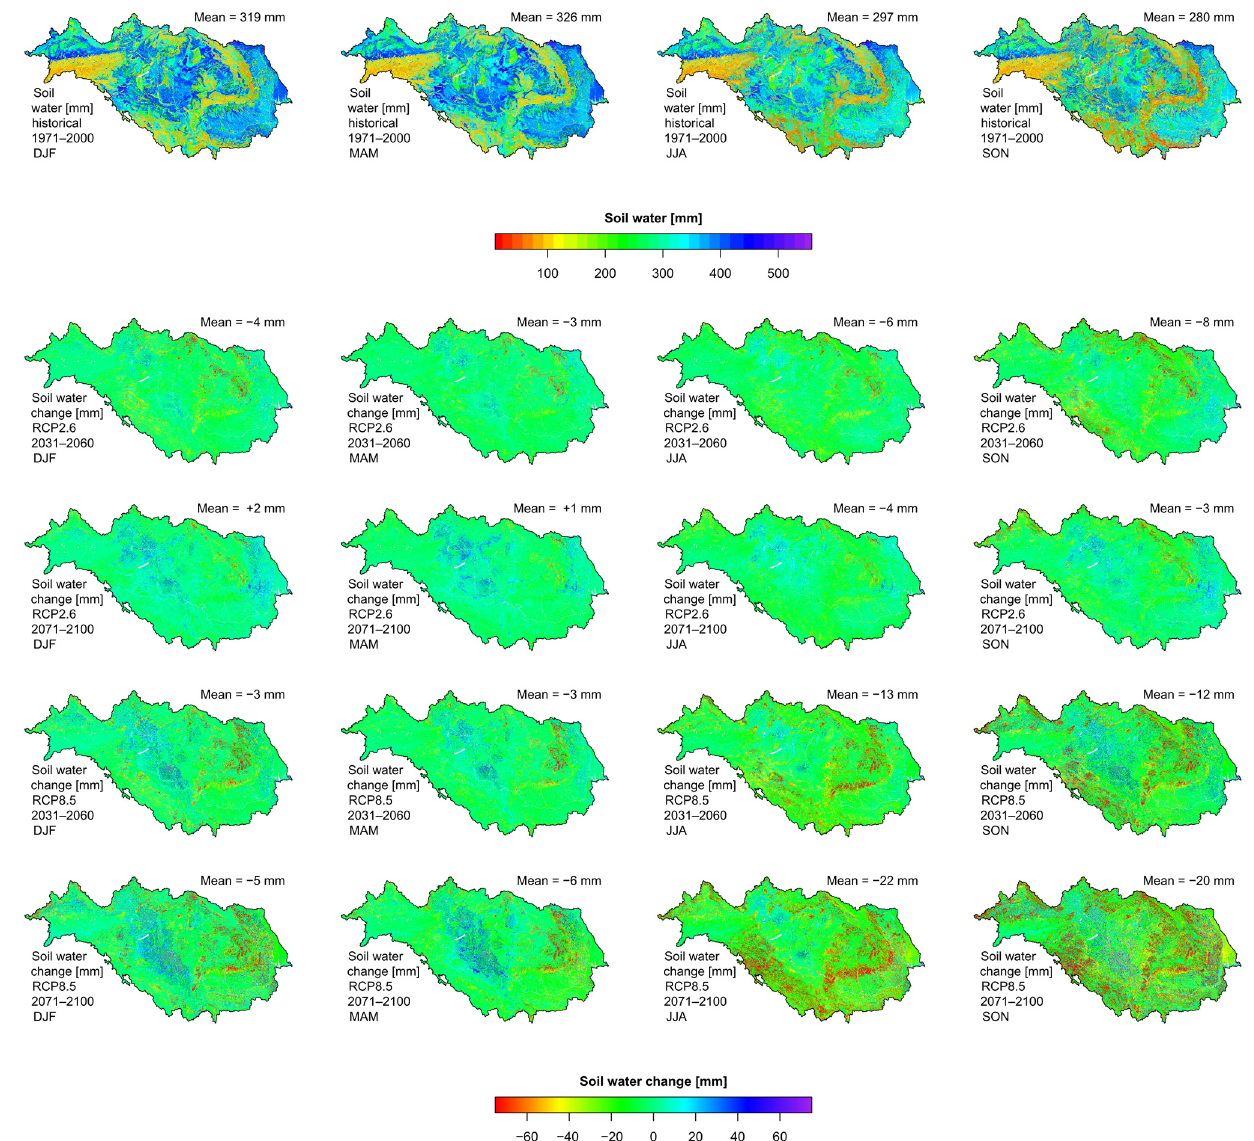
Figure 9. Maps of the long-term mean seasonal soil water content in the rooted zone [mm] for the historical GCM-RCM-driven simulations (ensemble mean, 1971–2000) as well as the long-term mean seasonal soil water change [mm] according to the GCM-RCM-driven simulations (ensemble mean) under RCP2.6 and RCP8.5 for the near future (2031–2060) and the far future (2071–2100) in the Danube River Basin.